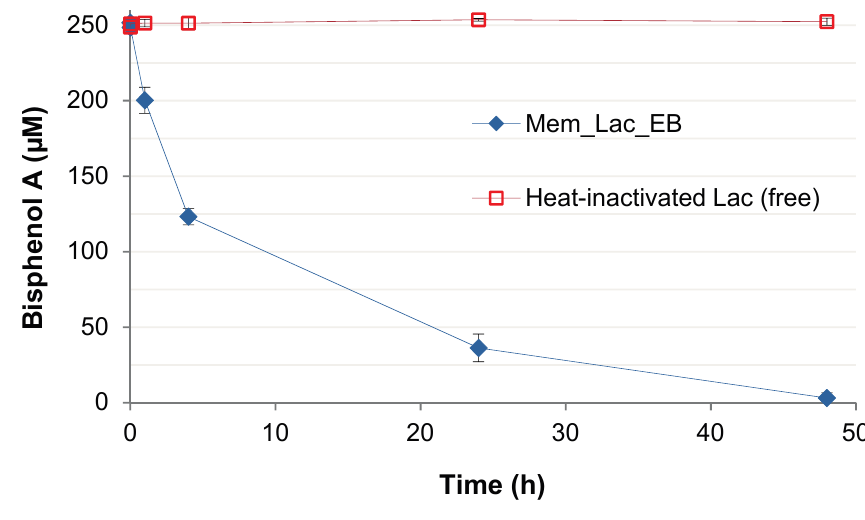
Figure 6. Time courses of BPA concentrations in degradation experiments employing irradiated laccase-containing membranes (Mem_Lac_EB), and in control experiments where freely suspended (non-immobilized), heat-inactivated laccase was applied (please refer to the Experimental Section for details). Data represent means ± standard deviations for triplicate